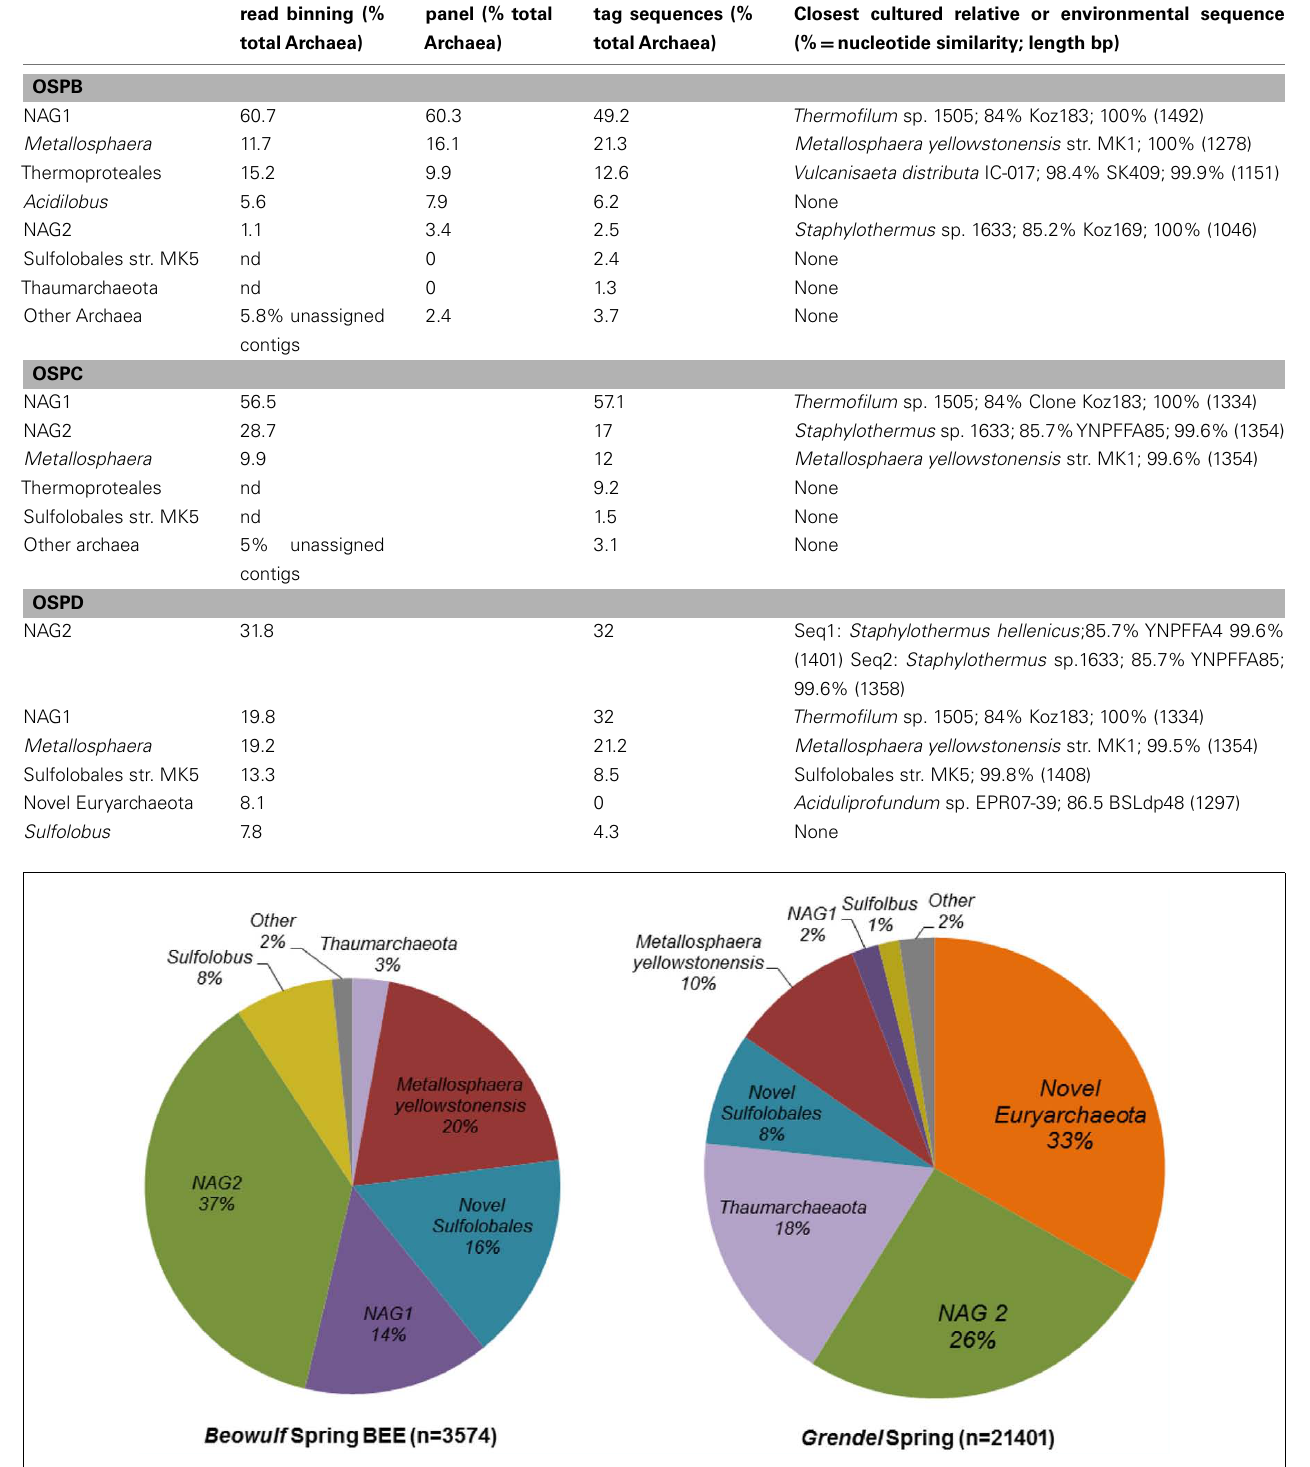
FIGURE 8 |Archaeal microbial community structure in two iron mat samples from Norris Geyser Basin presented as a percentage of total 16S rRNA gene pyrotag sequences that binned to different phylogenetic groups based on libraries of long-fragment sequences specific to these